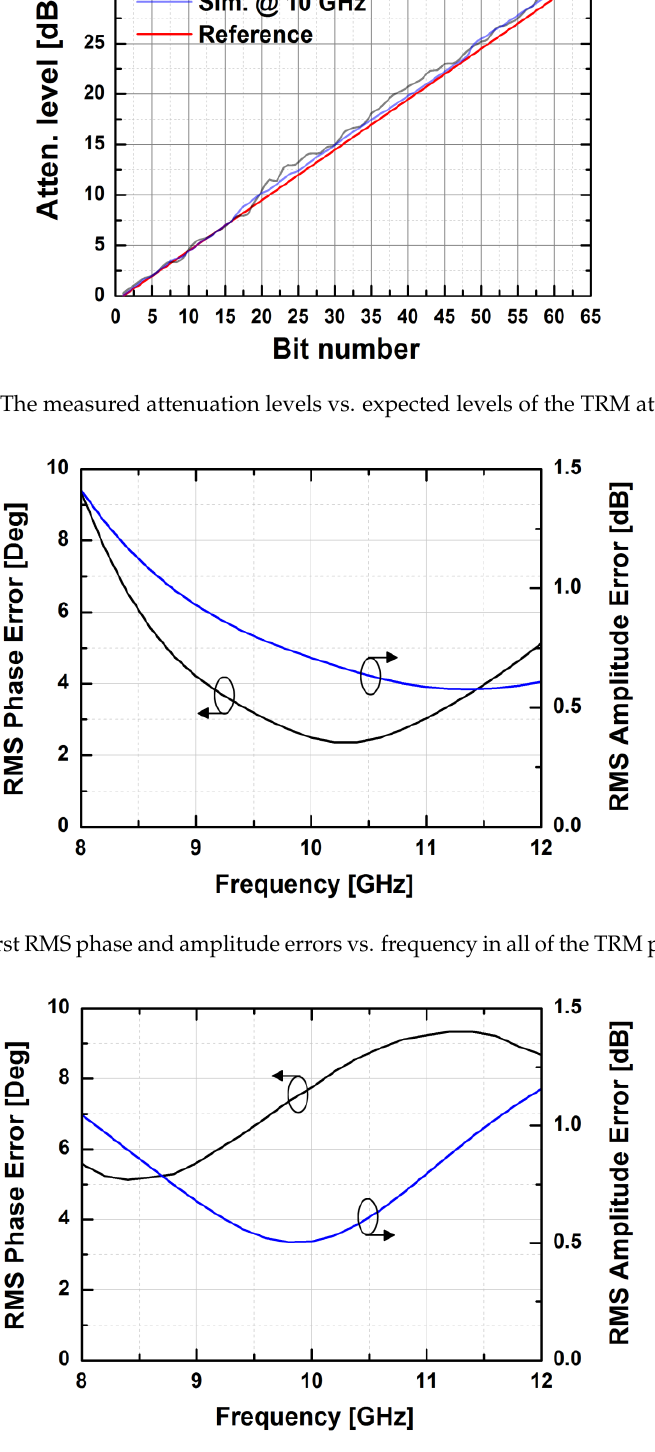
Figure 29. The worst RMS phase and amplitude errors vs. frequency in all of the TRM attenuation states.